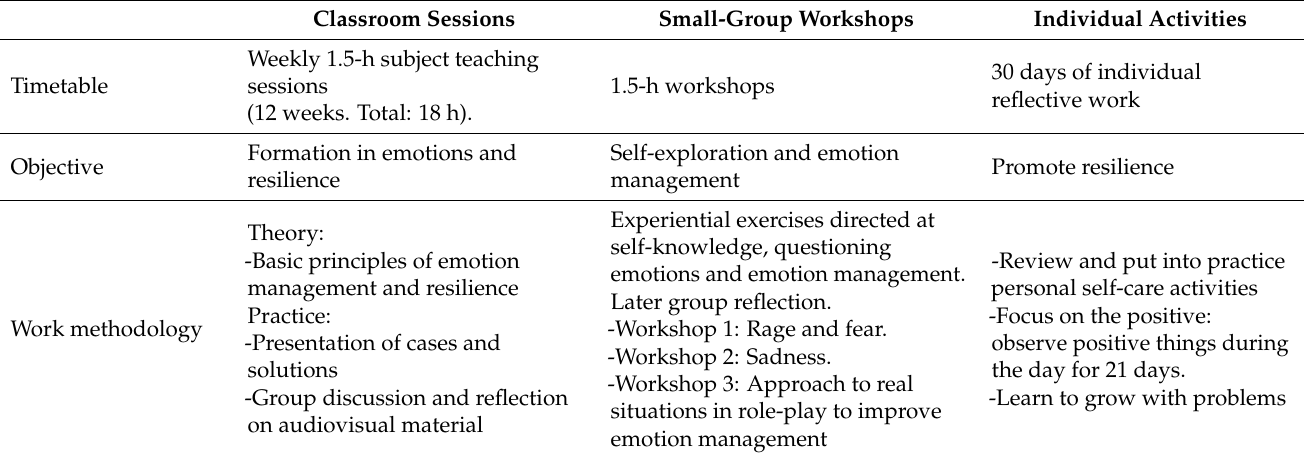
Table 1. Non-technical skills training